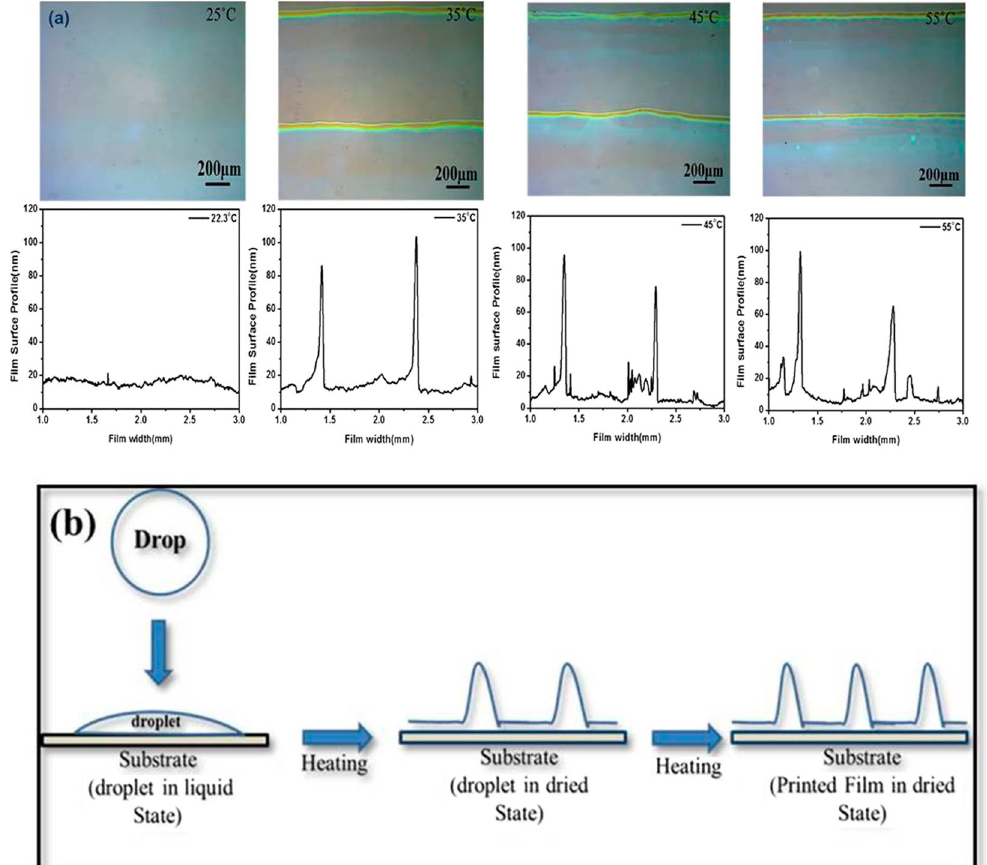
Figure 3. ( a ) Optical images and 2D profiles of printed NiO films at various substrates temperature on ITO/ glass substrates with UVO surface treatment, keeping the drop spacing at 50 μ m. ( b ) Schematic diagram of drying behavior of NiO film at higher substrate temperatures during